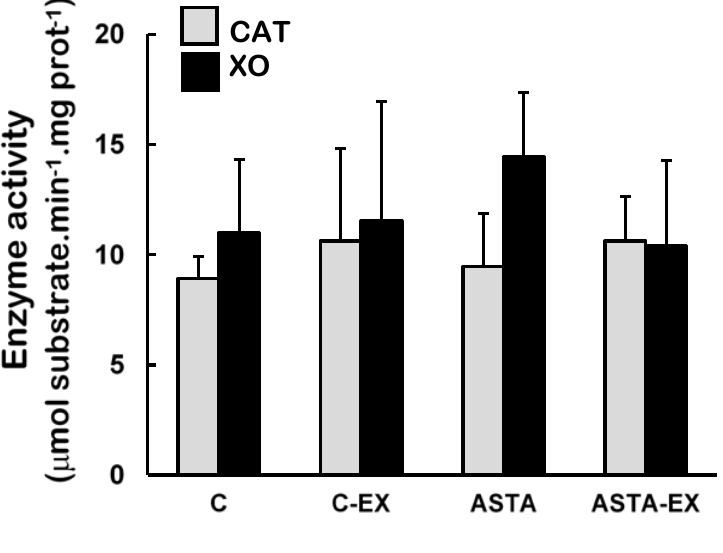
Figure 4. Enzyme activities of catalase (CAT) and xanthine oxidase (XO) in soleus muscles of Wistar rats submitted to exhaustion (forced swimming activity with additional 5% BW) and supplemented for 45 days with 1 mg ASTA/kg BW (ASTA or ASTA-EX) or mineral oil as control (C or C-EX). ( n =